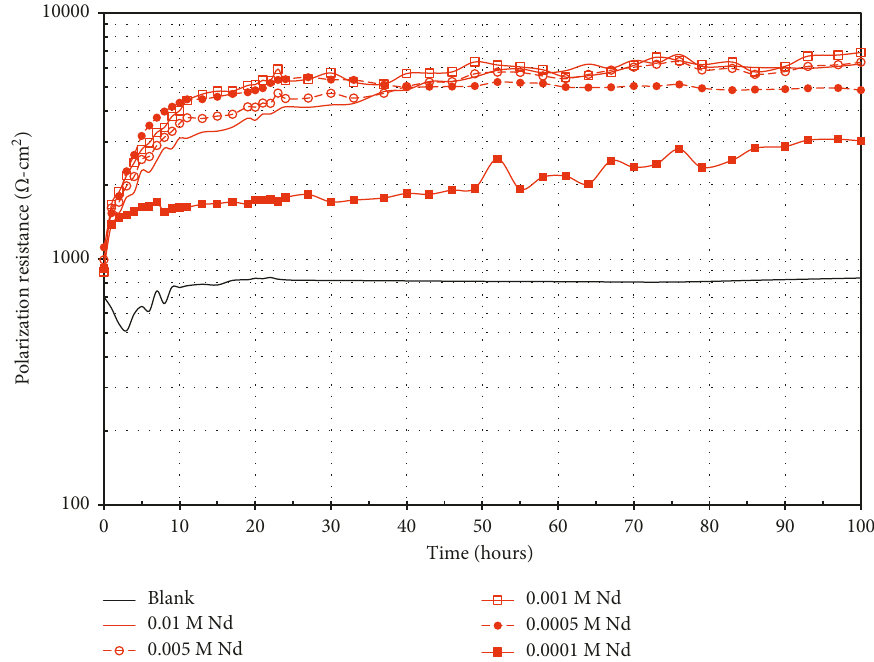
Figure 4: Variation in polarization resistance values for API X70 steel in 3.5% NaCl solution at different concentrations of Nd 3+